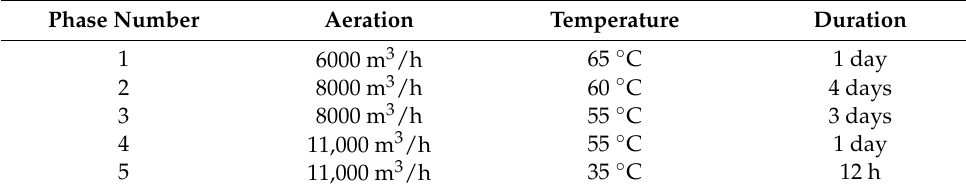
Table 1. Technological conditions for the bio-drying process.